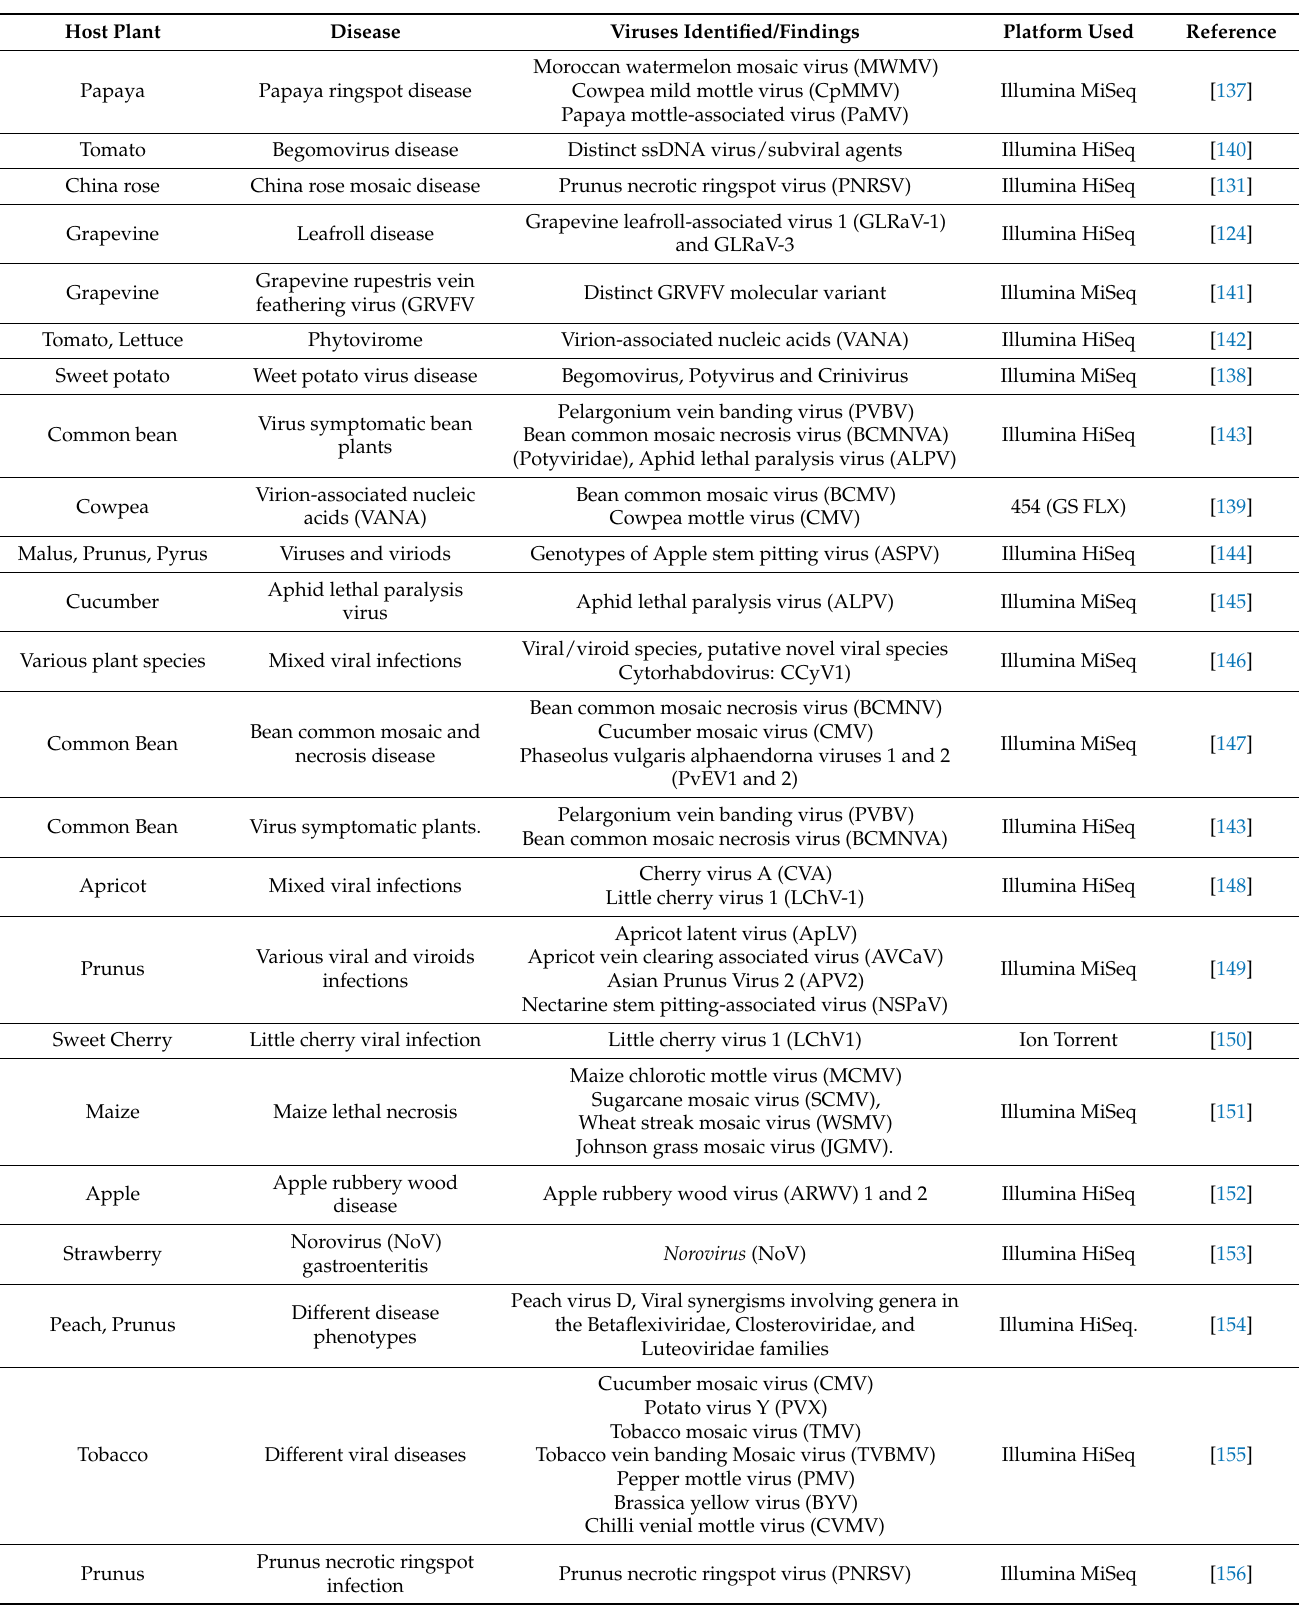
Table 3. Next-generation sequencing (second-generation sequencing platforms)-based identification of causative agents associated with the viral diseases of various